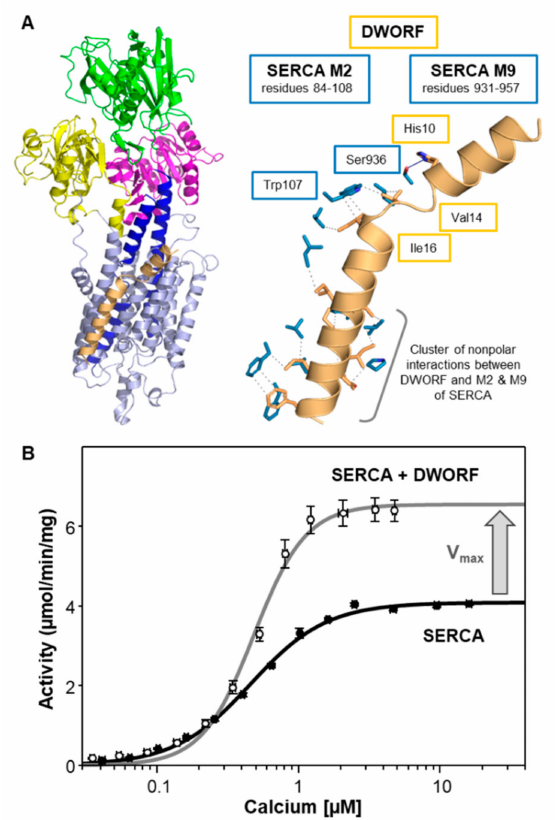
Figure 4. SERCA and dwarf open reading frame (DWORF). ( A ) Molecular model of the SERCA- DWORF complex [25]. DWORF is colored tan. SERCA is colored light blue with the actuator domain in yellow, the phosphorylation domain in magenta, the nucleotide-binding domain in green, and transmembrane segments M4 and M5 in blue. Also shown are the side-chain interactions between SERCA (blue) and DWORF (tan). The relative locations of SERCA transmembrane segments M2 and M9 are indicated. Key interactions between DWORF and SERCA are indicated. For the full list of interactions, refer to Table S3. ( B ) Calcium-dependent ATPase activity of SERCA reconstituted into membrane vesicles in the absence (black) and presence of DWORF (gray). The change in the maximal activity (V max ) of SERCA is indicated by an arrow. Each data point is the mean ± standard error ( n ≥